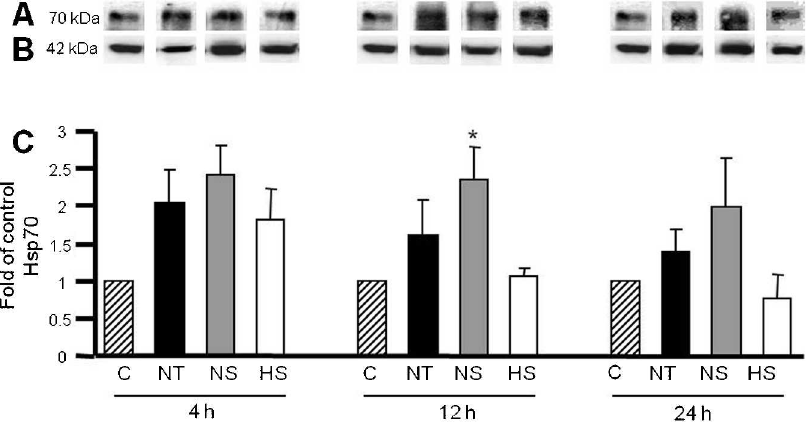
Figure 6 - Hepatic expression of Hsp70; densitometric analysis of Western blots (C); and representative film of Hsp70 protein expression (A). (B) b -actin was used as the loading control (100 m g protein/lane). Data are means ¡ SEM, n = 4 in each group. * P , 0.05 vs.